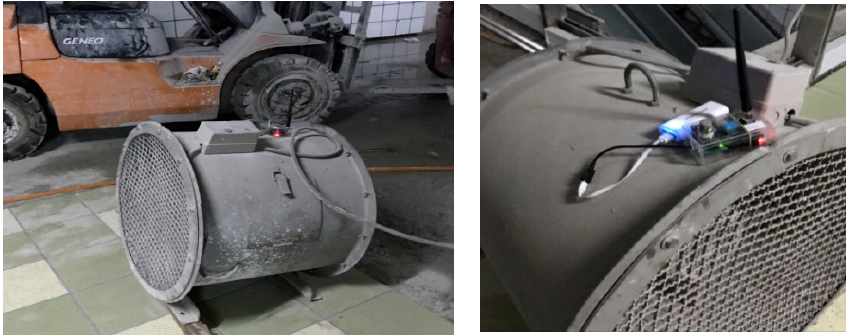
Figure 19 . The interference test of sensor node.